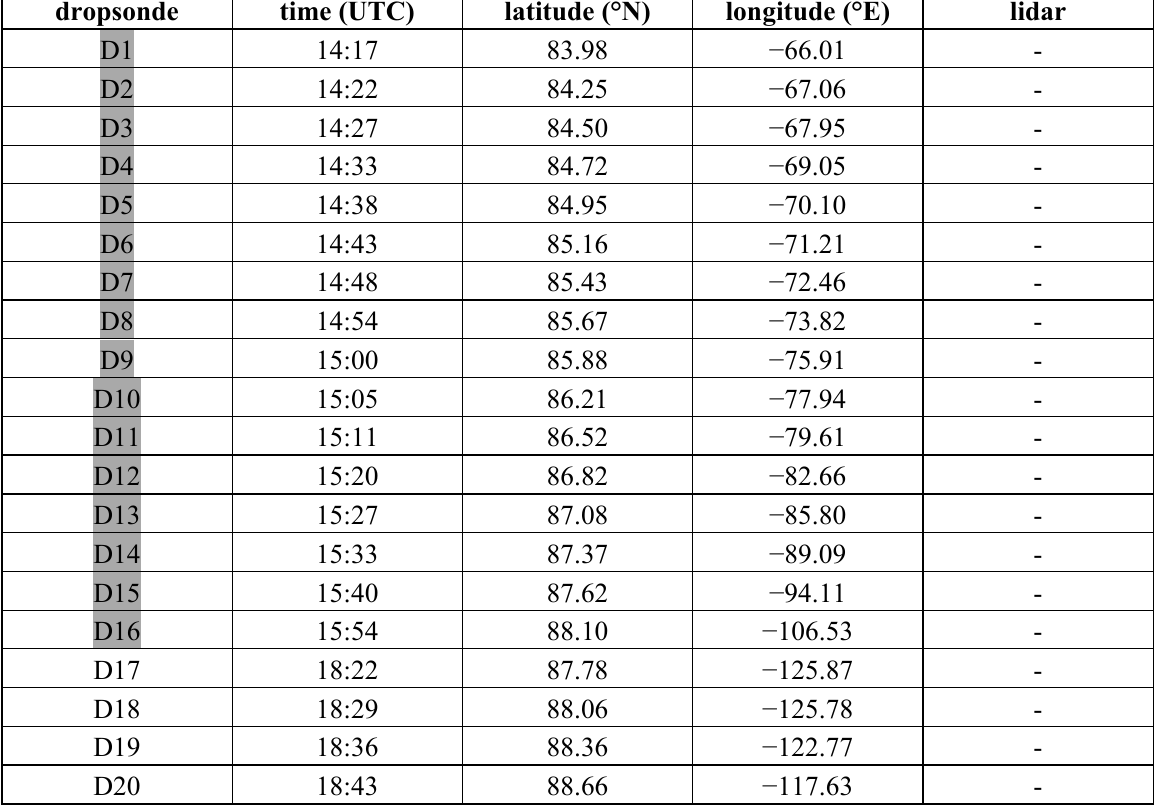
Table 4. Launch times and locations of the dropsonde measurements on 10 April 2009. The sondes used for case study D are highlighted in